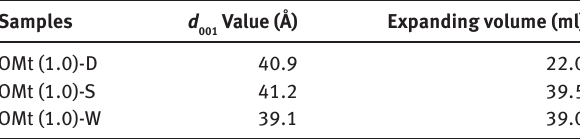
value and dispersibility. 001